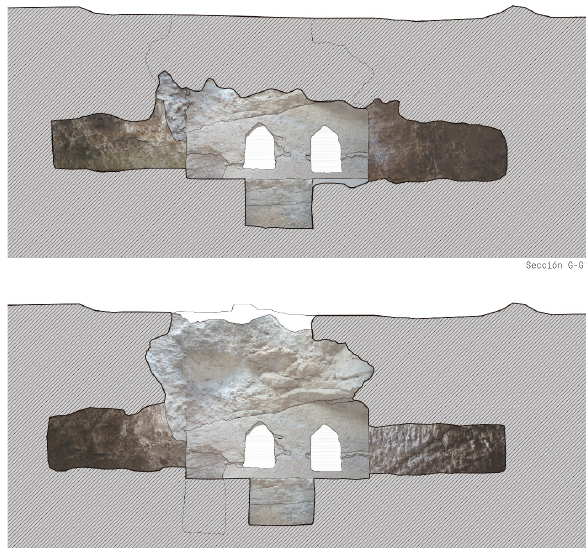
Figure 8. The burial chamber: cross-sections of the space.